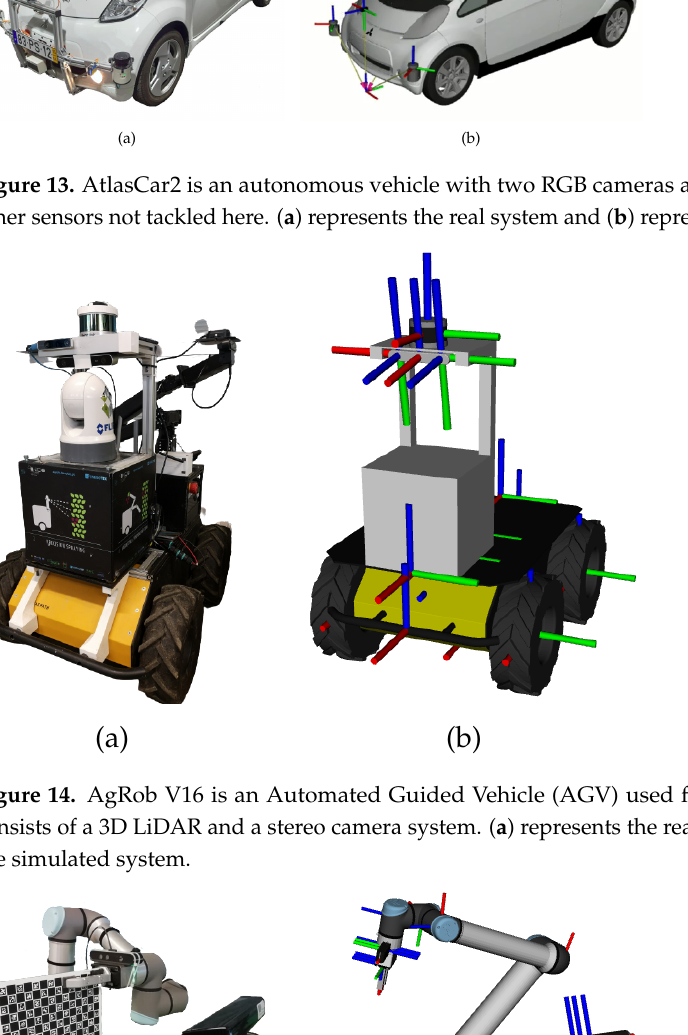
Figure 15. Iris UR10e is a robotic system comprised of a robotic manipulator with two RGB cameras, one fixed to the end-effector of the robotic manipulator and another mounted on a tripod. ( a ) represents the real system and ( b ) represents the simulated